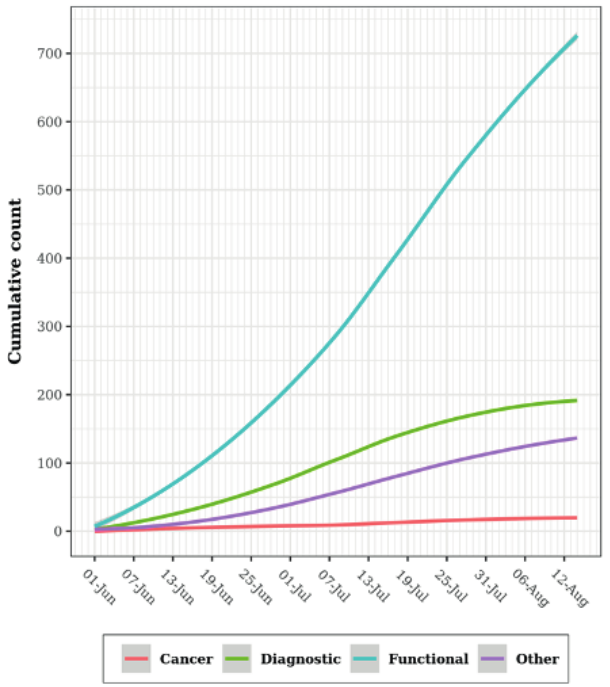
Figure 3. Changes in capacity over time. The operative procedures